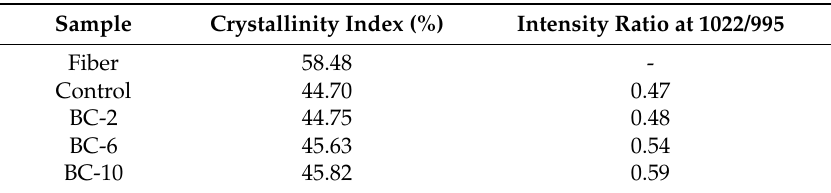
Table 2. Crystallinity index of starch and biocomposite films.